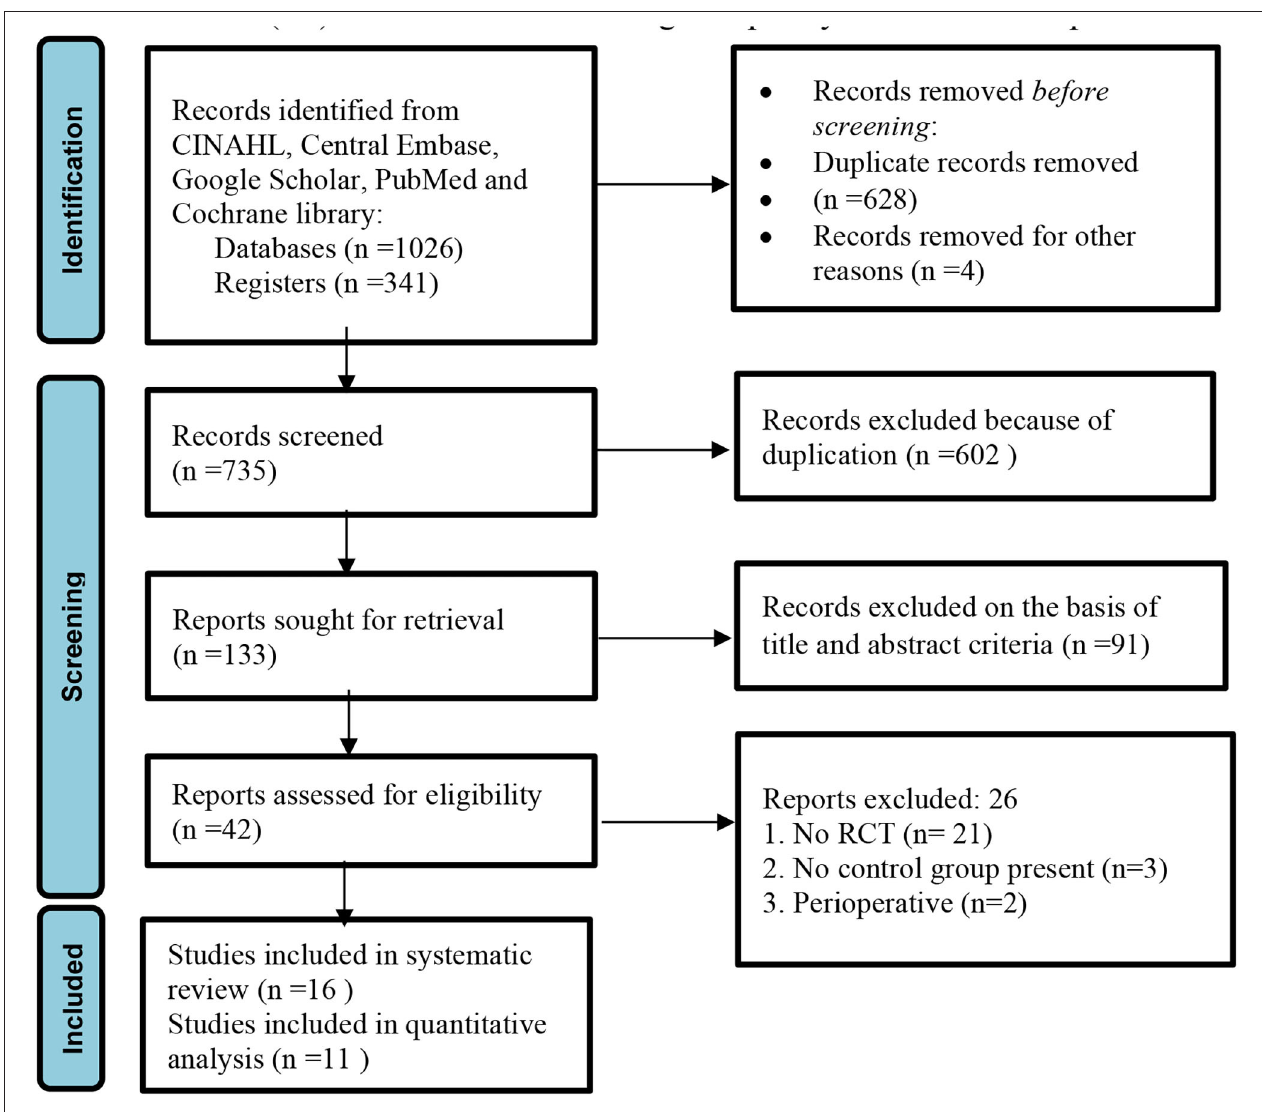
FIGURE 1 | PRISMA flow diagram of the study